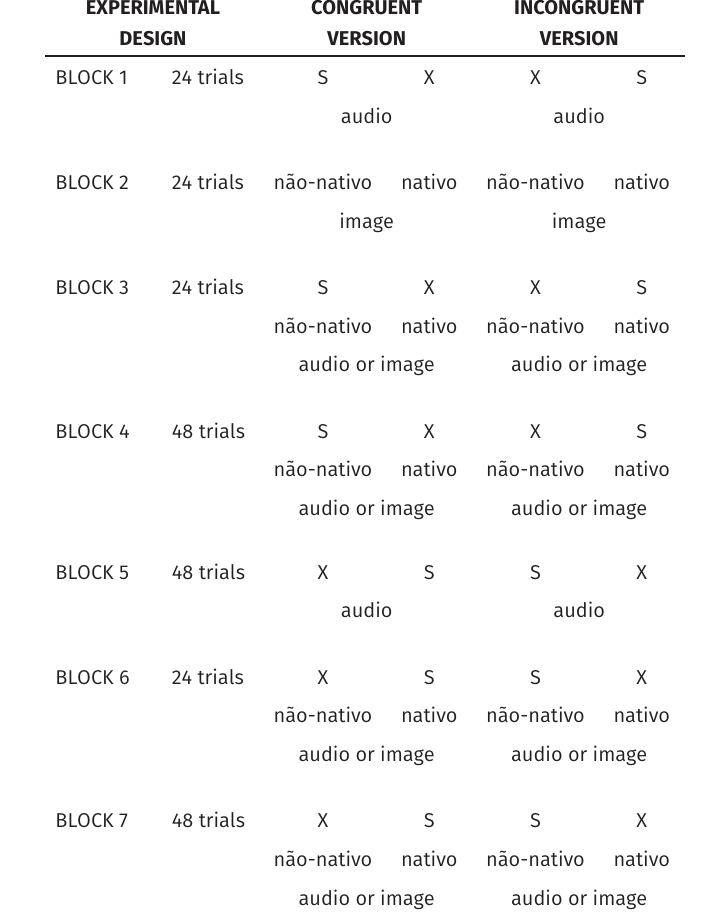
Table 1: Implicit Association Test